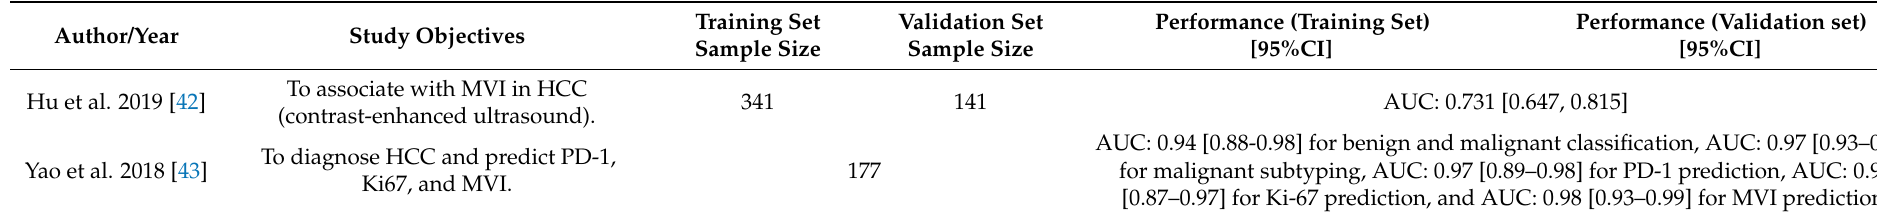
Table 6. Performance of radiomics approaches (US underlying